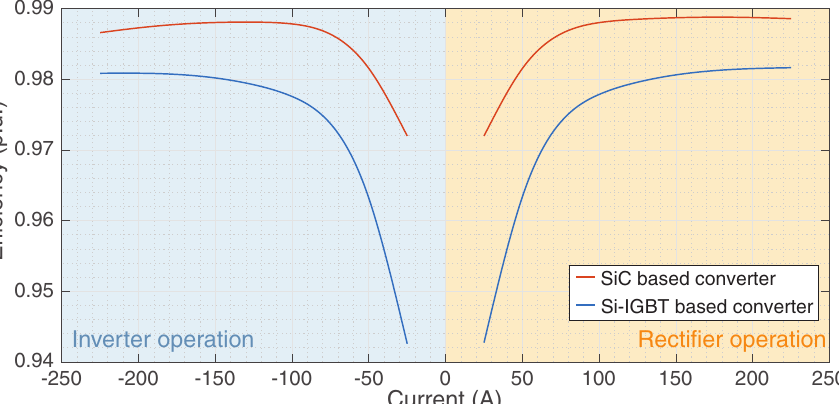
Figure 15. Converter efficiency in both modes of operation (Cos( φ ) = [–1, 1] and M = 1.15) for both the SiC-MOSFET converter and the Si-IGBT converter.